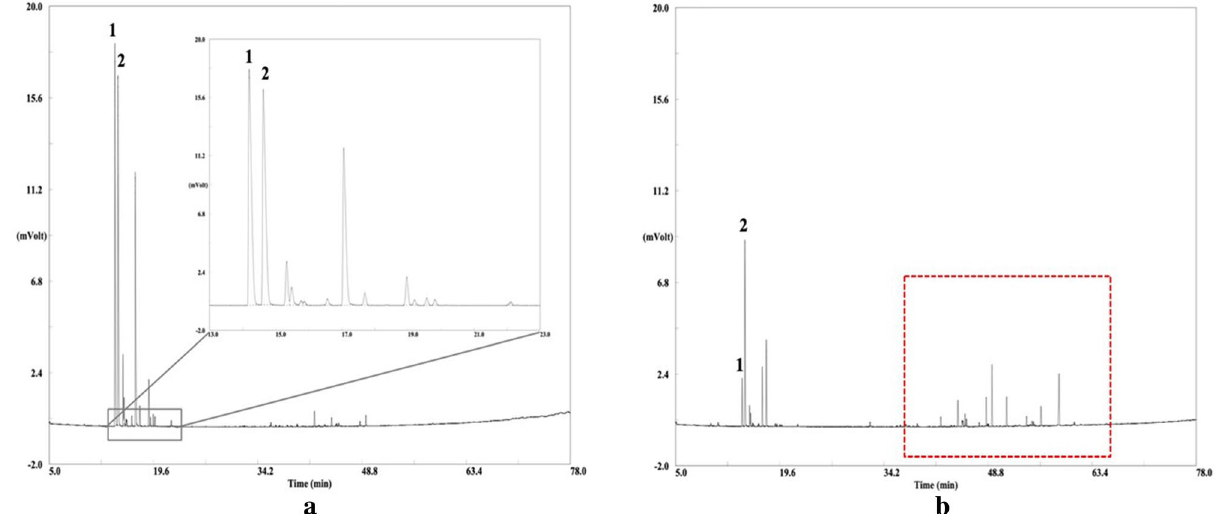
Figure 1. ( a ) Chromatographic profile obtained by chiral gas chromatography-flame ionization detector of a commercial essential oil of P. sylvestris ( 1 ) and ( b ). primary essential oil of P. sylvestris ( 36 ) with (−)-α-pinene ( 1 , RT: 14.3 min, RI cal: 977, RI lit: 977) and (+)-α-pinene ( 2 , RT: 14.7 min, RI cal: 983, RI lit: 980). The red square indicates the distinct sesquiterpene profile, which was lacking in commercial